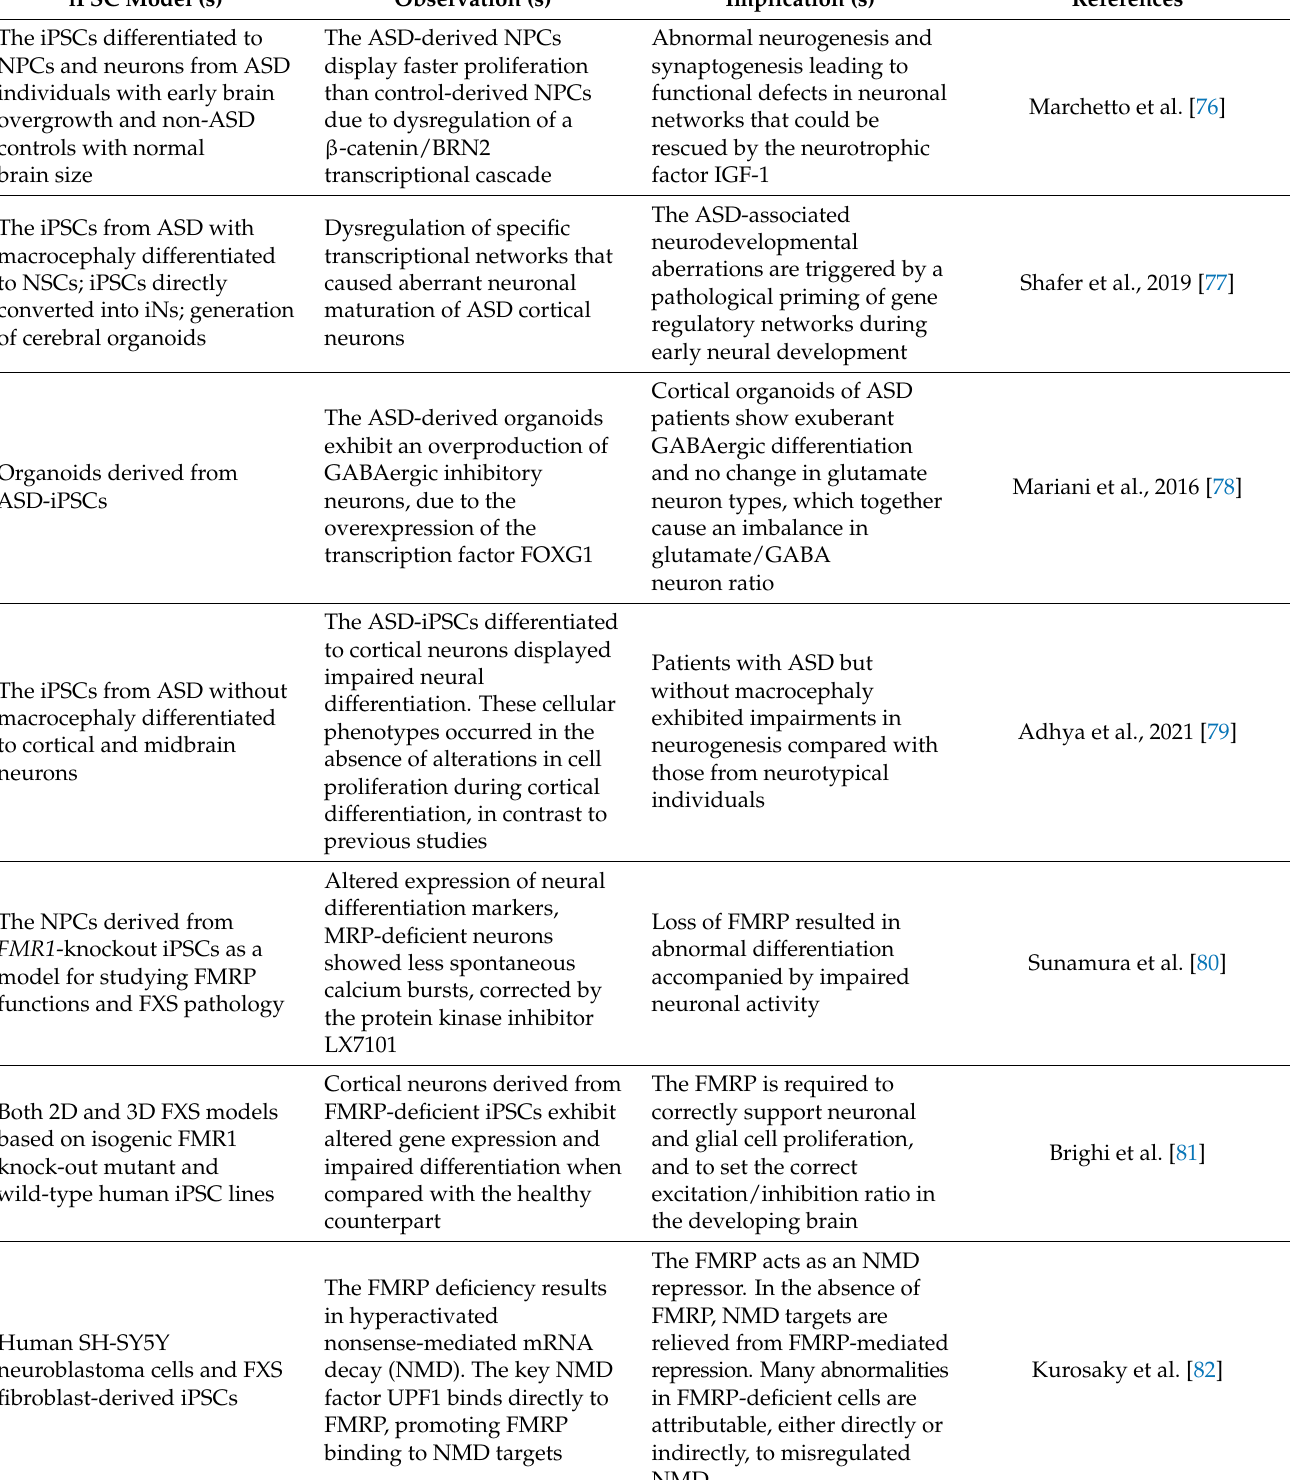
Table 4. Selected studies investigating autism spectrum disorder using iPSCs from